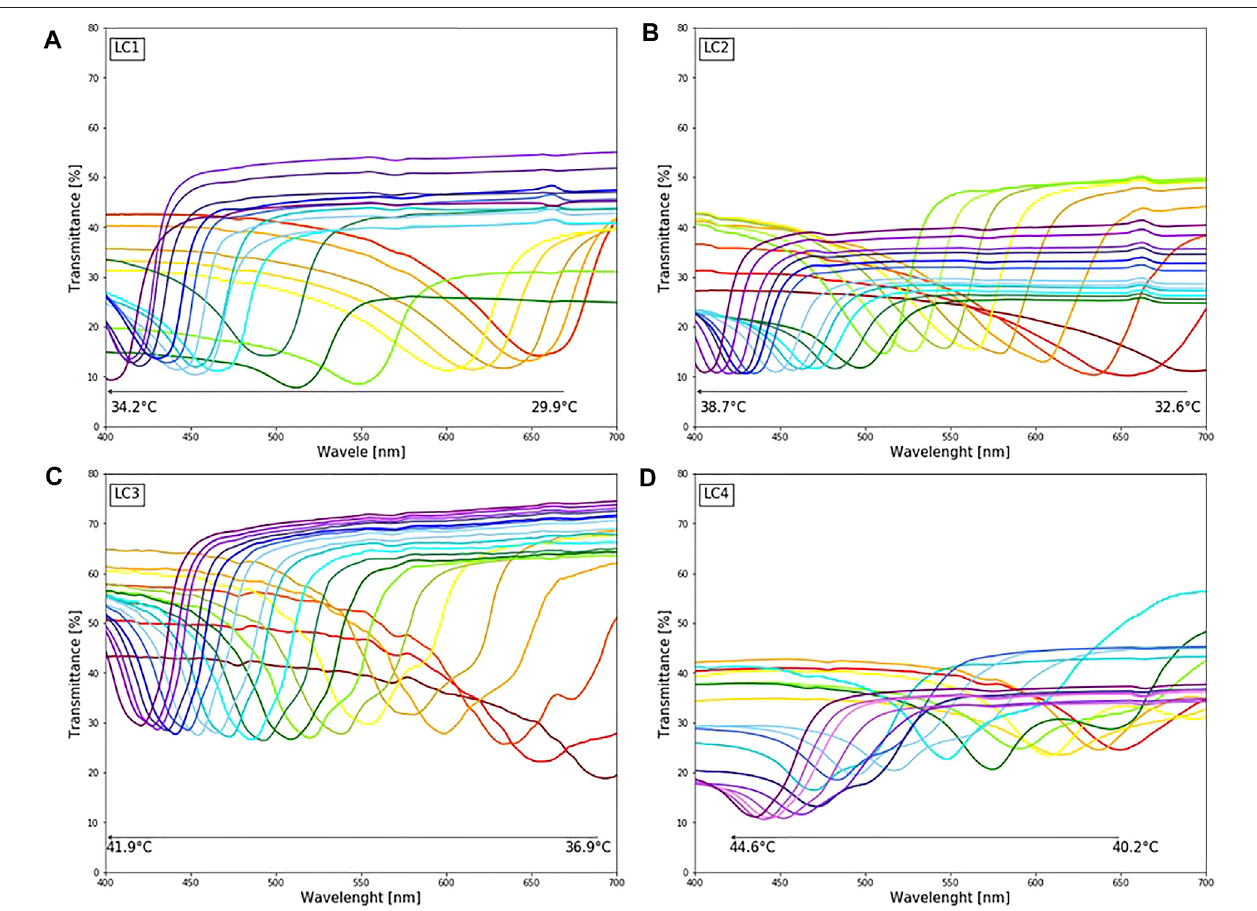
FIGURE 3 | The colorimetric response of different LC upon changing temperature (29.9 – 44.6 ° C): (A) LC1: re fl ection peaks in the visible spectrum for temperature range 29.9 – 35 ° C (B) LC2: re fl ection peaks in the visible spectrum for temperature range 32.6 – 38.7 ° C (C) LC3: re fl ection peaks in the visible spectrum for temperature range 36.9 – 41.9 ° C (D) LC4: re fl ection peaks in the visible spectrum for temperature range 40.9 – 44.7 °